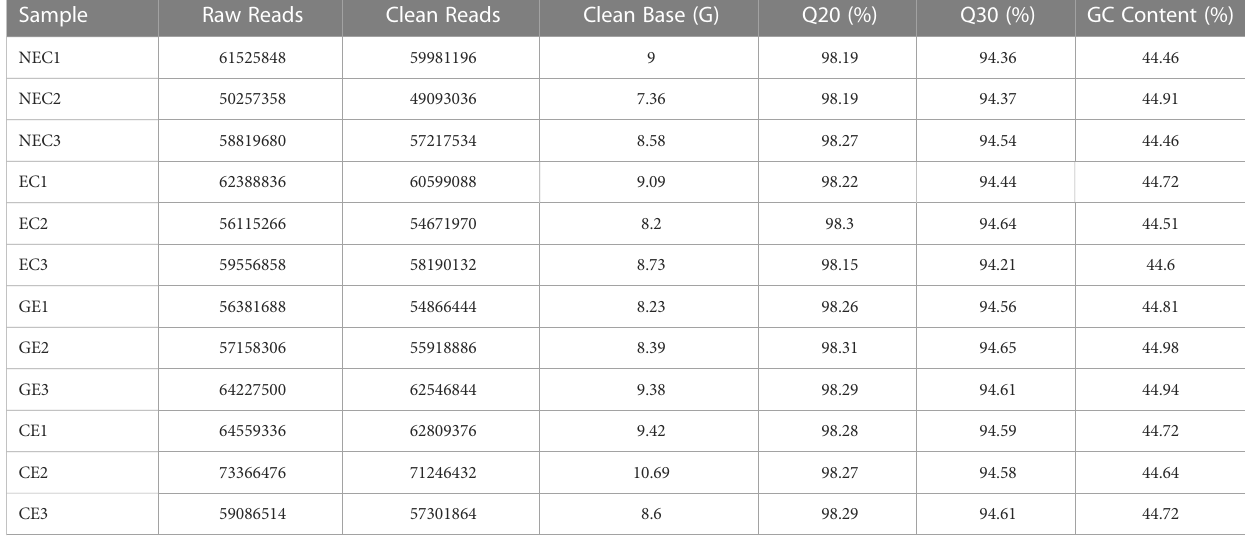
TABLE 2 Transcriptome sequence analysis of 12 samples from different SE stages of O. henryi .